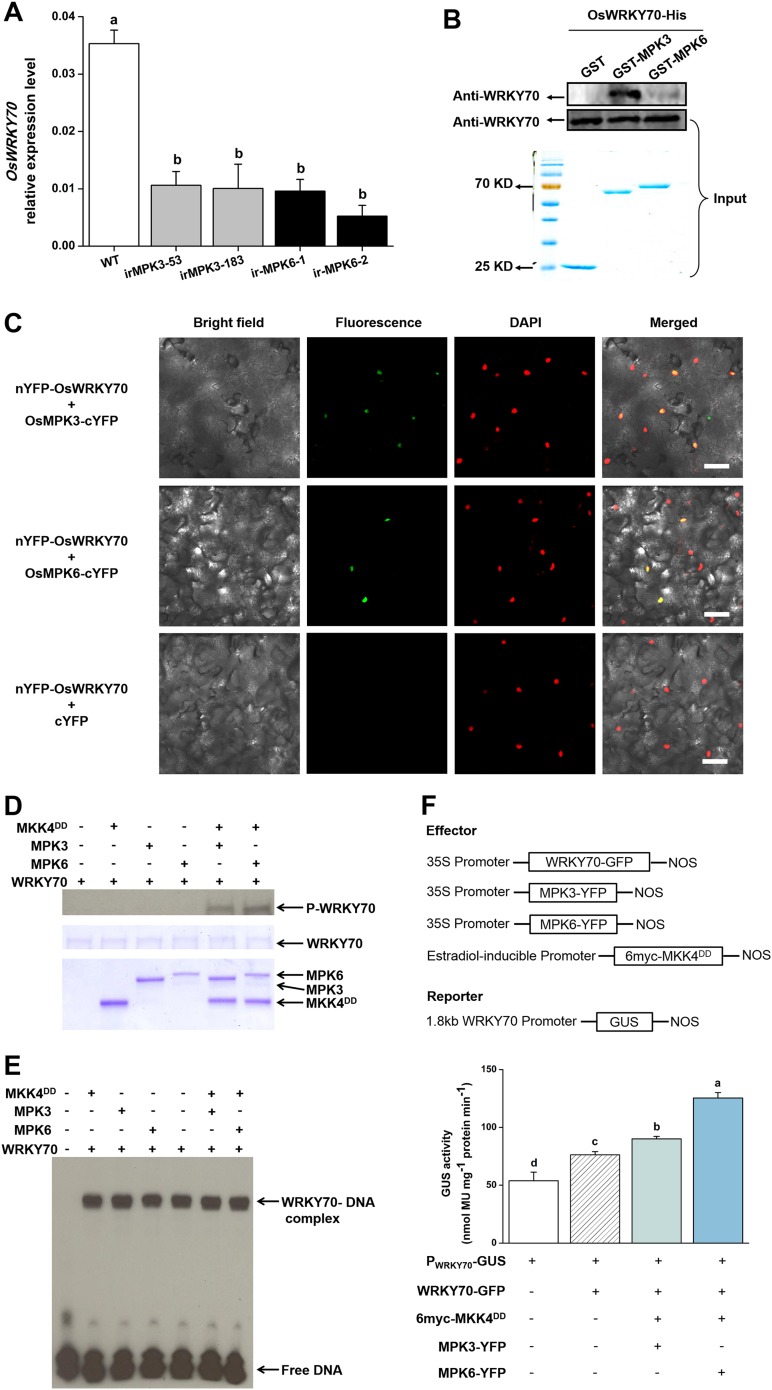
Interactions between OsWRKY70 and OsMPK3/6.(A) Mean transcript levels (+SE, n = 5) of OsWRKY70 in transgenic lines with silencing of OsMPK3 (irMPK3 lines, irMPK3-53, and irMPK3-183) or OsMPK6 (irMPK6 lines, irMPK6-1, and irMPK6-2) after infested by SSB for 1 hr. (B) In vitro interaction assays between OsWRKY70 and OsMPK3 or OsMPK6. GST, GST-MPK3, and GST-MPK6 purified proteins were incubated with WRKY70-His as indicated. WRKY70-His input and pulled-down fractions were analyzed by immunoblotting using anti-WRKY70 antibody (top). Input proteins were monitored by Coomassie blue staining (bottom). This experiment was repeated 3 times with similar results. (C) In vivo bimolecular fluorescence complementation interaction assays between OsWRKY70 and OsMPK3 or OsMPK6. Fluorescence was observed from complementation of the N-terminal part of the YFP fused with OsWRKY70 (nYFP-OsWRKY70) with OsMPK3 or OsMPK6 fused with the C-terminal part of the YFP (OsMPK3-cYFP or OsMPK6-cYFP) and co-localized with DAPI stains in the nuclear compartment of tobacco leaf cells. No fluorescence was observed when nYFP-OsWRKY70 was co-expressed with unfused cYFP. Scale bar, 50 μm. (D) In vitro phosphorylation of OsWRKY70 by OsMPK3/6. The phosphorylated form of OsWRKY70 (P-WRKY70) was detected by using Phos-tag Biotin BTL-104 (top). Input proteins, including OsWRKY70-His (WRKY70), GST-OsPMK3 (MPK3), GST-OsPMK6 (MPK6), and His-OsMKK4DD (MKK4DD) were monitored by Coomassie blue staining. (E) Assays for W-box binding activity of OsWRKY70. GST-OsMPK3 or GST-OsMPK6 was activated by a constitutively active form of OsMKK4, His-OsMKK4DD. BS65 containing two W-boxes was used as the probe. (F) Assays for transactivation activity of OsWRKY70. Leaves of N. benthamiana were agroinfiltrated with the indicated constructs. 24 hr later, leaves were injected with 10 mM 17-β-estradiol and were incubated for 12 hr. Total protein was extracted and GUS activities were subsequently quantified. Eight plants were used for each treatment. Letters indicate significant differences among different lines (A) or treatments (F) (p < 0.05, Duncan's multiple range test).